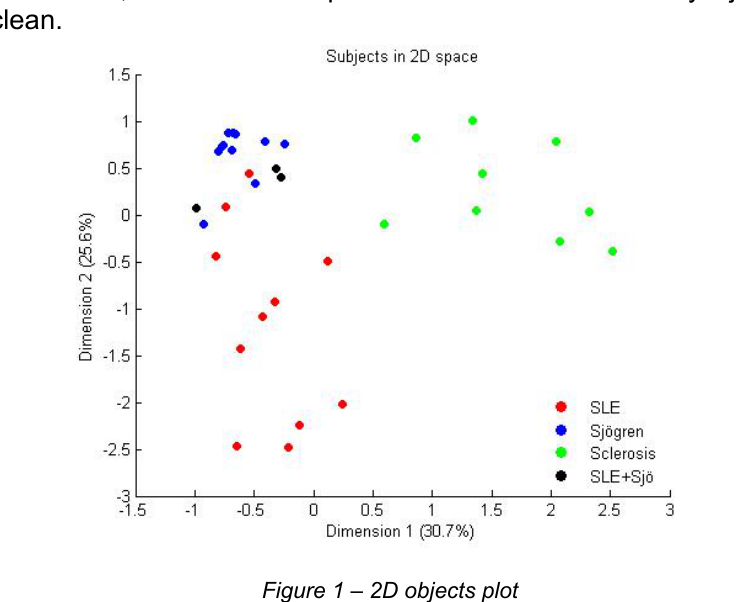
Рис . 1 – 2 Д изображение объектов на